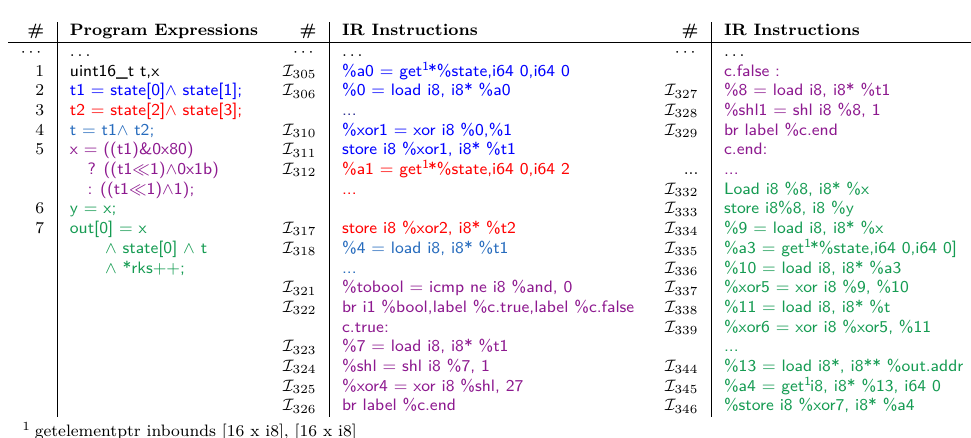
Figure 2: The software implementation for single byte MixColumns operation of AES and corresponding IR Instructions. Different colors represent the mapping of operations in software implementation to IR instructions. The IR instructions are numbered I 305 to I 346 according to their positions considering the whole AES